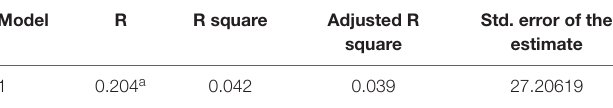
TABLE 6 | Model summary for Chinese EFL PC and